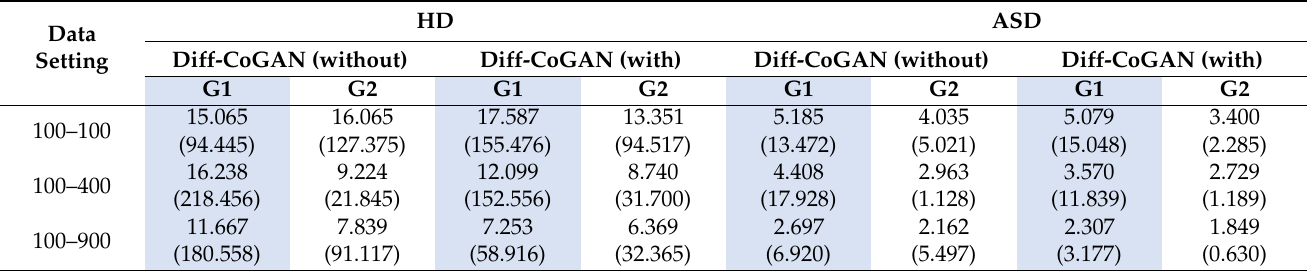
Table 10. The HD and ASD of Diff-CoGAN with and without intersection for the Spleen dataset. Similar to the experimental results of the Hippocampus dataset, the HD and ASD values demonstrate that the intersection operation reduces the boundary error and improves segmentation.